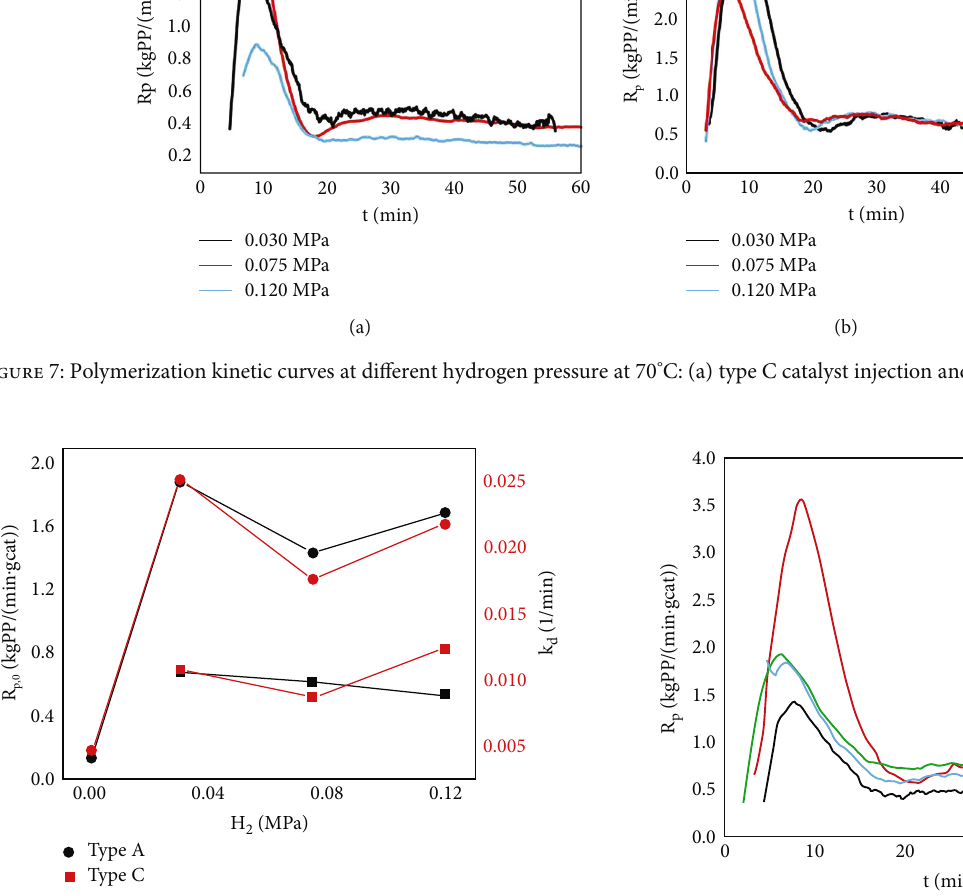
Figure 8: E ff ect of hydrogen partial pressure on polymerization kinetic parameters.